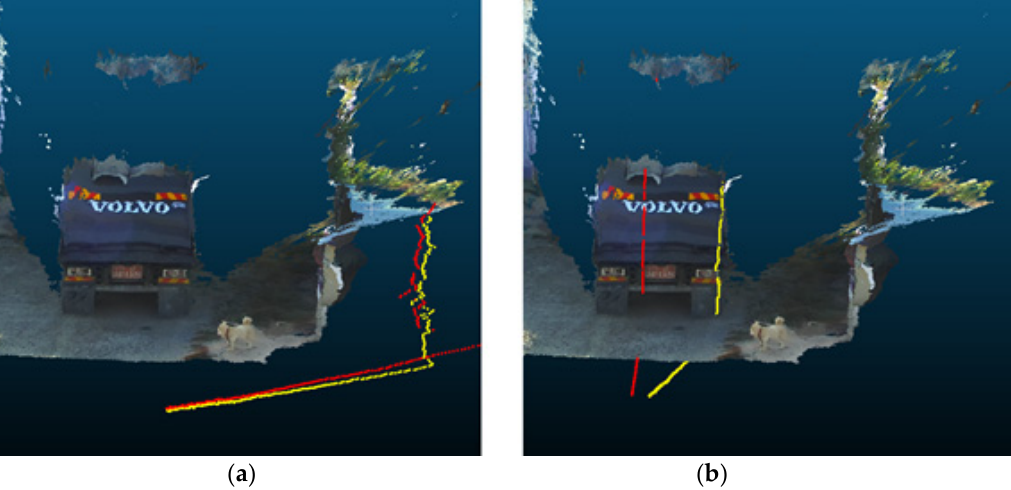
Figure 6. The result of projecting data from two LiDAR sensors on a dense 3D point cloud obtained from a stereo camera. The red line is the left LIDAR sensor, and the yellow line is the right LIDAR sensor. The left side of the sensor: ( a ) the result before correction; ( b ) the result after correction.